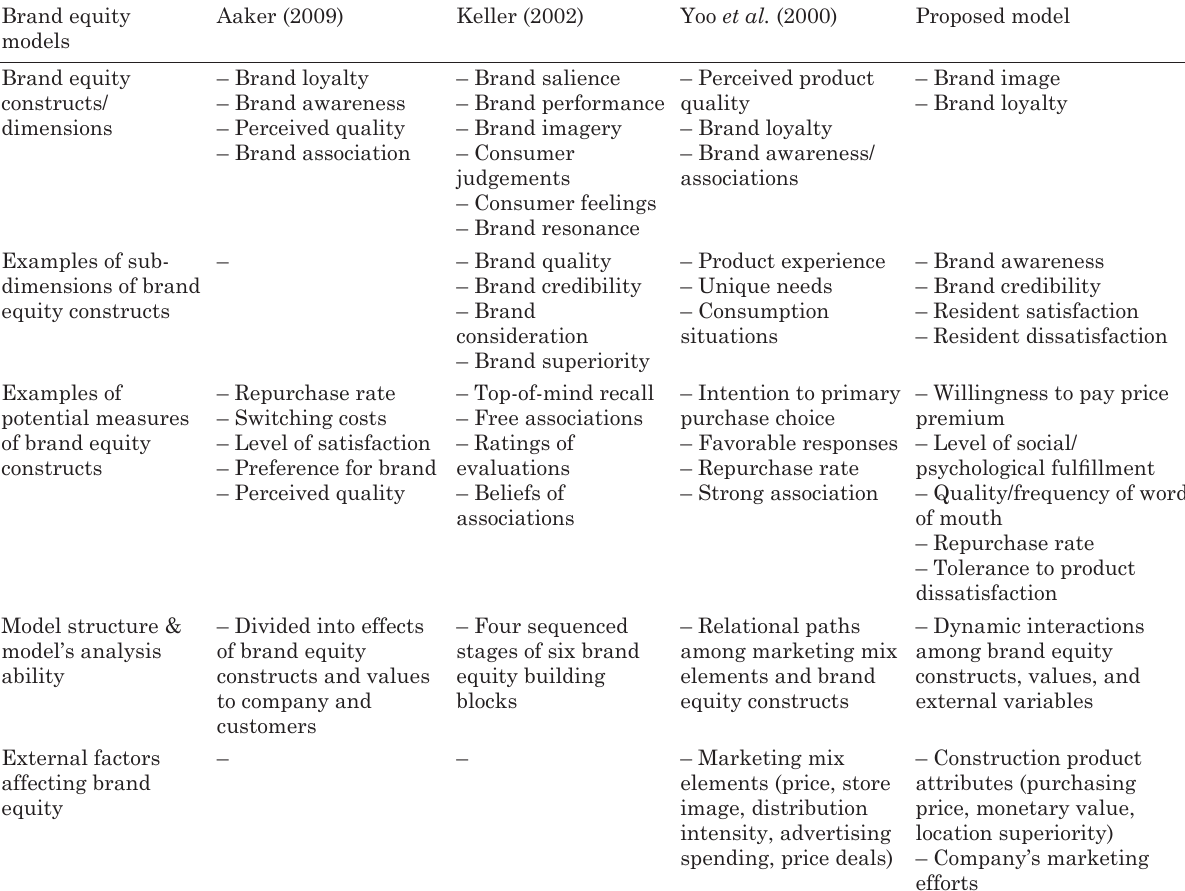
Table 2. Brand equity model comparisons Brand equity